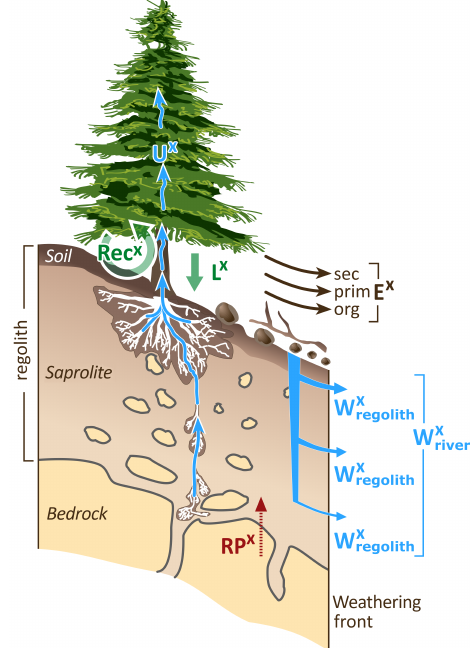
Figure 4. Schematic figure illustrating the metrics used in our flux model. “Org” refers to the sum of coarse woody debris (CWD), lit- ter and trunk wood erosion. Rec X refers to the nutrient recycling factor of element X , U X refers to the nutrient uptake flux of ele- ment X , L X refers to the litter flux of element X , RP X refers to the regolith production flux of element X , W X refers to the dissolved river river flux of element X and W X refers to the net solubilisation regolith flux of element X .